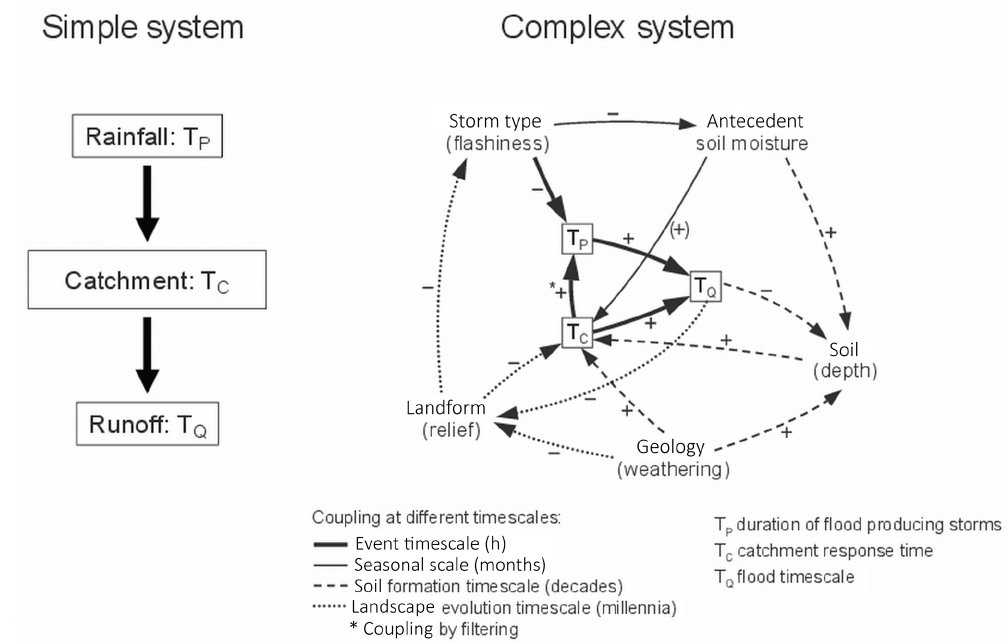
Figure 2. Simple and complex system representations of timescales contributing to floods. Interactions of multiple timescales make the response an emergent outcome of a complex system. Taken from Gaál et al.